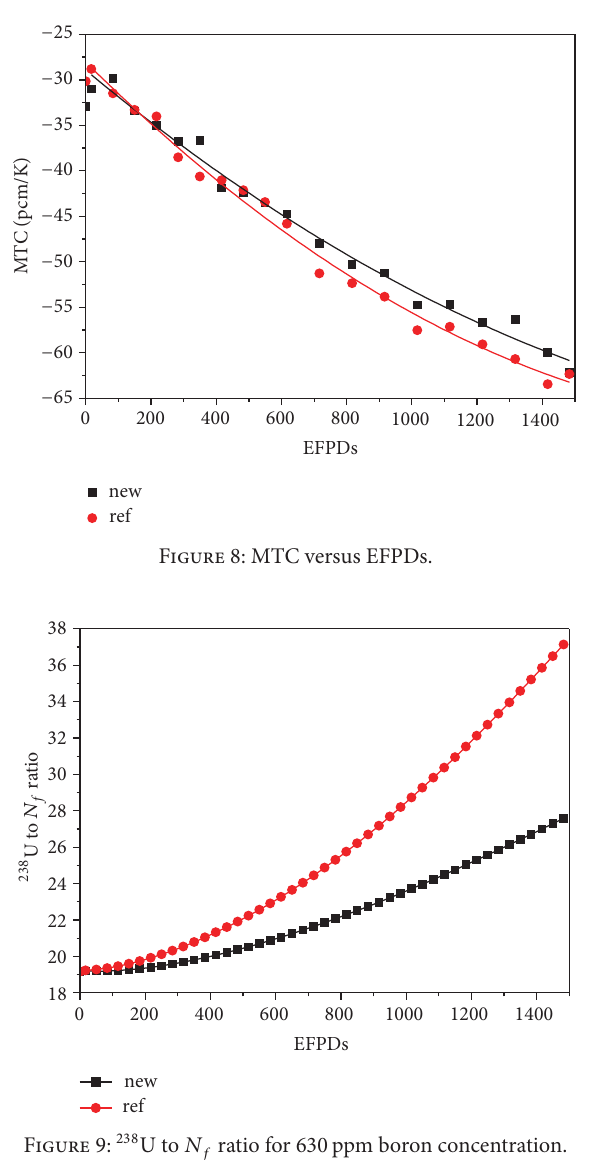
dividing the difference of reactivity by the corresponding difference of temperature.